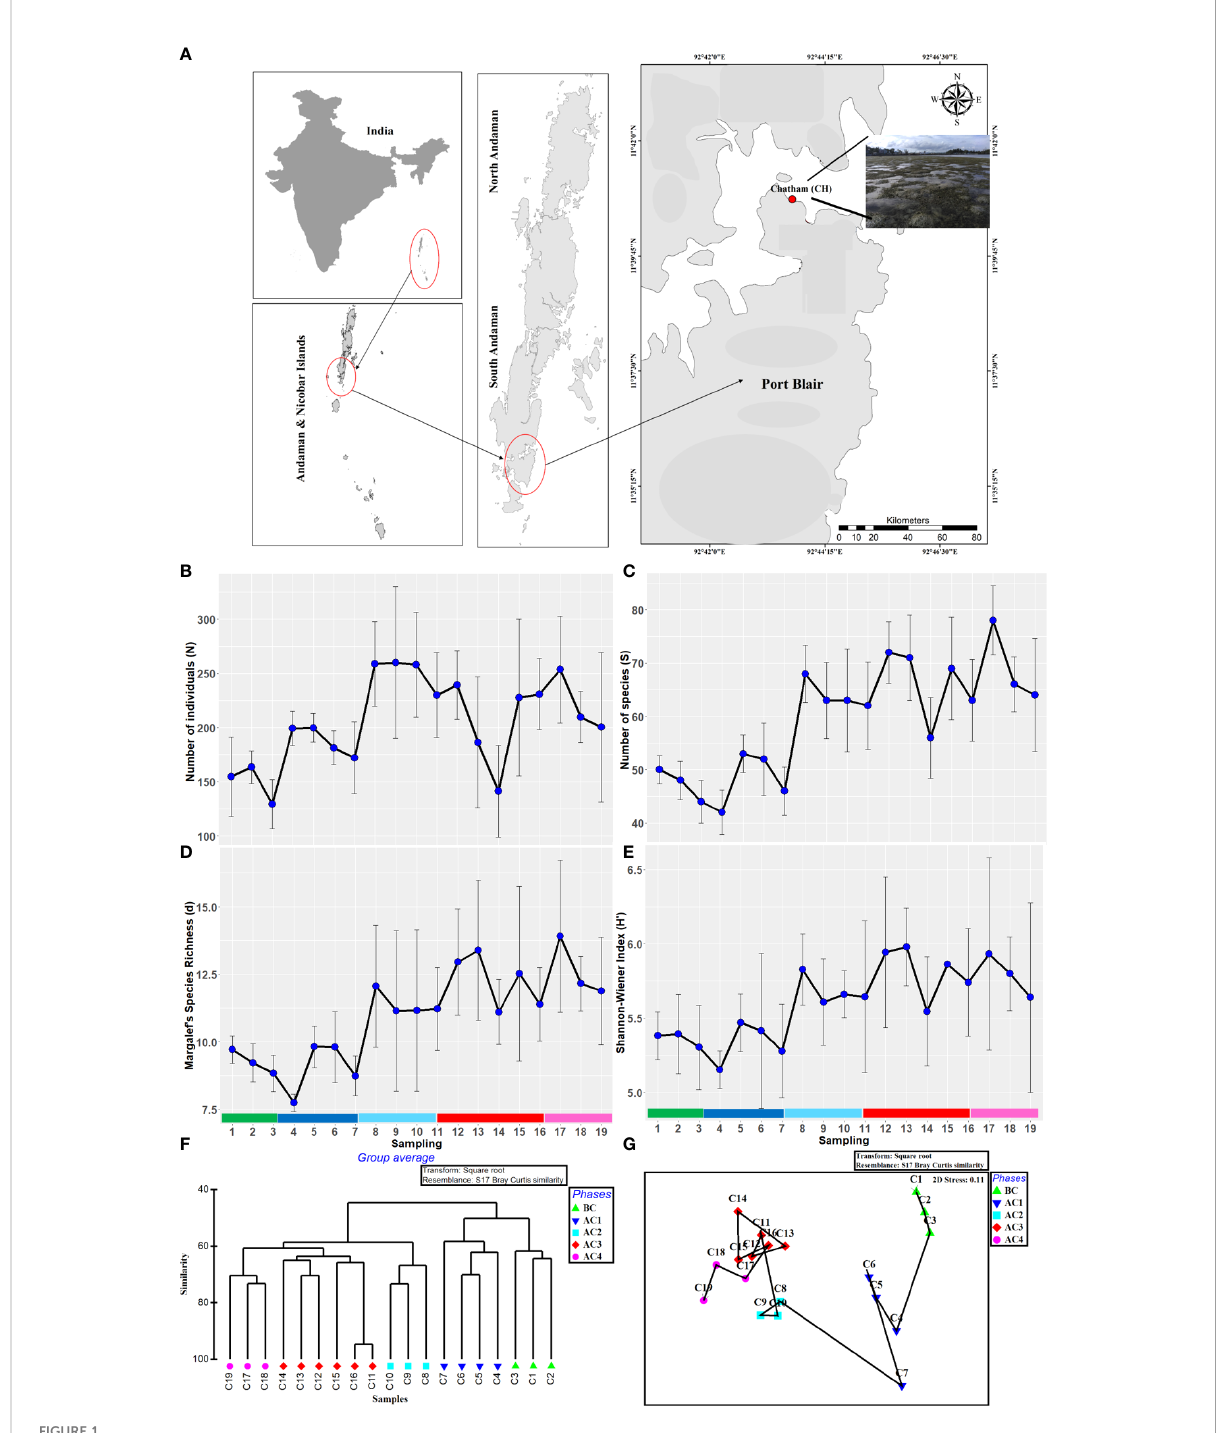
FIGURE 1 (A) Study area map. Macrobenthic community attributes: (B) number of individuals, (C) number of species, (D) Margalef ’ s index, (E) Shannon – Wiener index, (F) BC similarity dendrogram, and (G) nMDS plot. Sample size, n = 9 for panels (B – E) . The color shades on the x-axis of line diagram depict cyclonic phases as shown in dendrogram and nMDS plot. BC, before cyclone; AC1, after cyclone phase 1; AC2, after cyclone phase 2; AC3, after cyclone phase 3; AC4, after cyclone phase